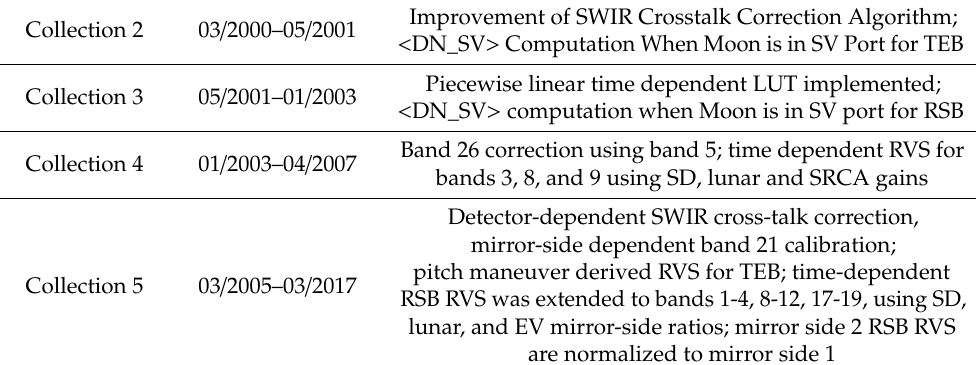
Table 4. Summary of Terra MODIS L1B data collections and key calibration